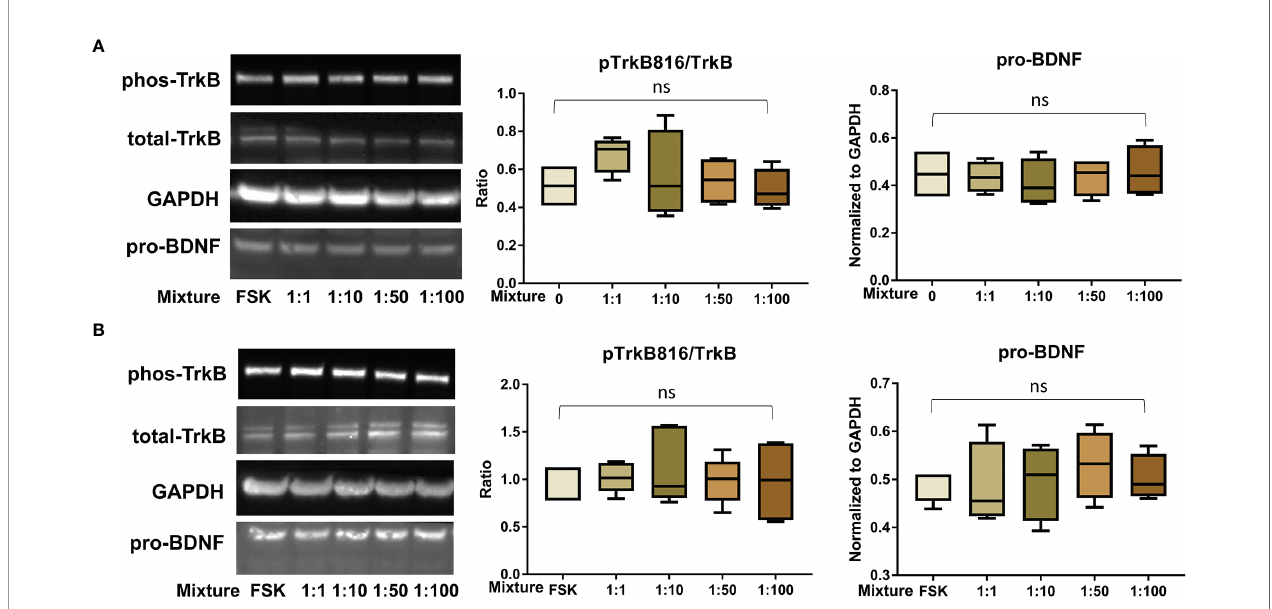
FIGURE 7 | PFAS mixture exposure (detailed in Table 1 ) did not signi fi cantly disrupt the BDNF-TrkB pathway. (A) Representative Western blot images of phos- TrkB, total-TrkB, GAPDH, and pro-BDNF in BeWo cells without forskolin (FSK) treatment exposed to mixture dilutions (0, 1:1, 1:10, 1:50, 1:100) and box plots for densitometry analysis; (B) Representative Western blot images of phos-TrkB, total-TrkB, GAPDH, and pro-BDNF in BeWo cells with FSK treatment exposed to mixture dilutions (0, 1:1, 1:10, 1:50, 1:100) and box plots for densitometry analysis. ns indicates differences in protein levels were not signi fi cant. pTrkB816 represents for phosphorylation of TrkB at Tyr816